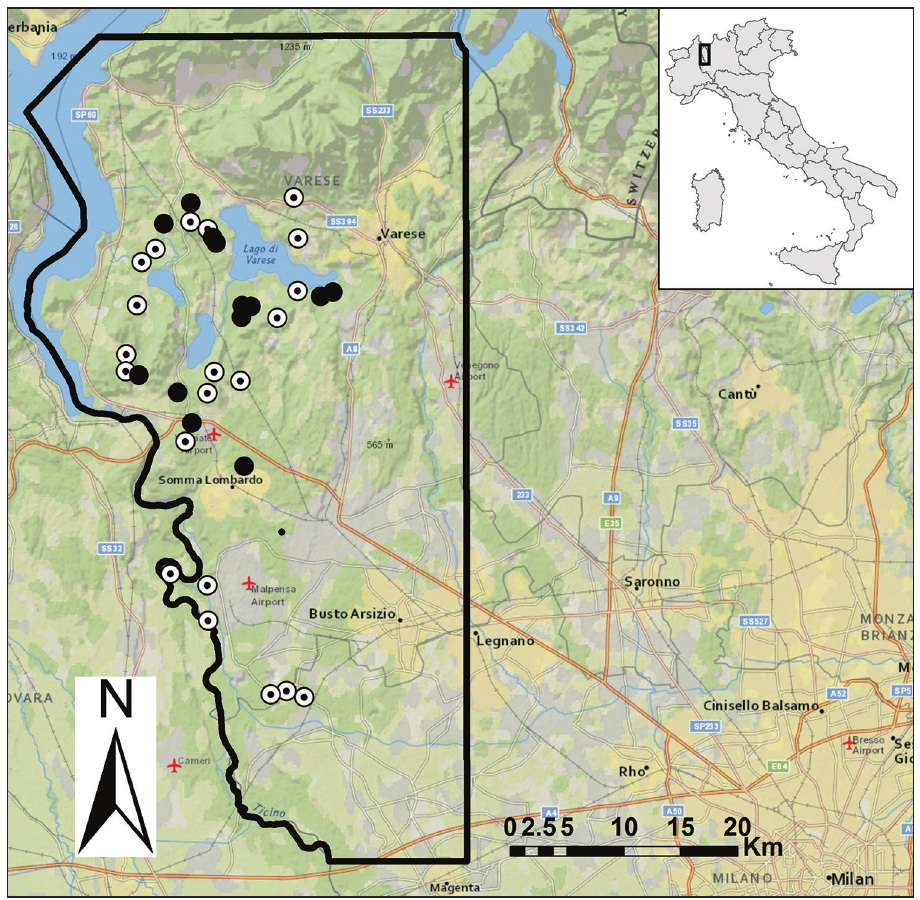
Figure 1. Study area and stag beetle sampling locations (black dots with white circles). Filled black dots in- dicate investigated sites where the species was not recorded. Black lines indicate the borders of the study